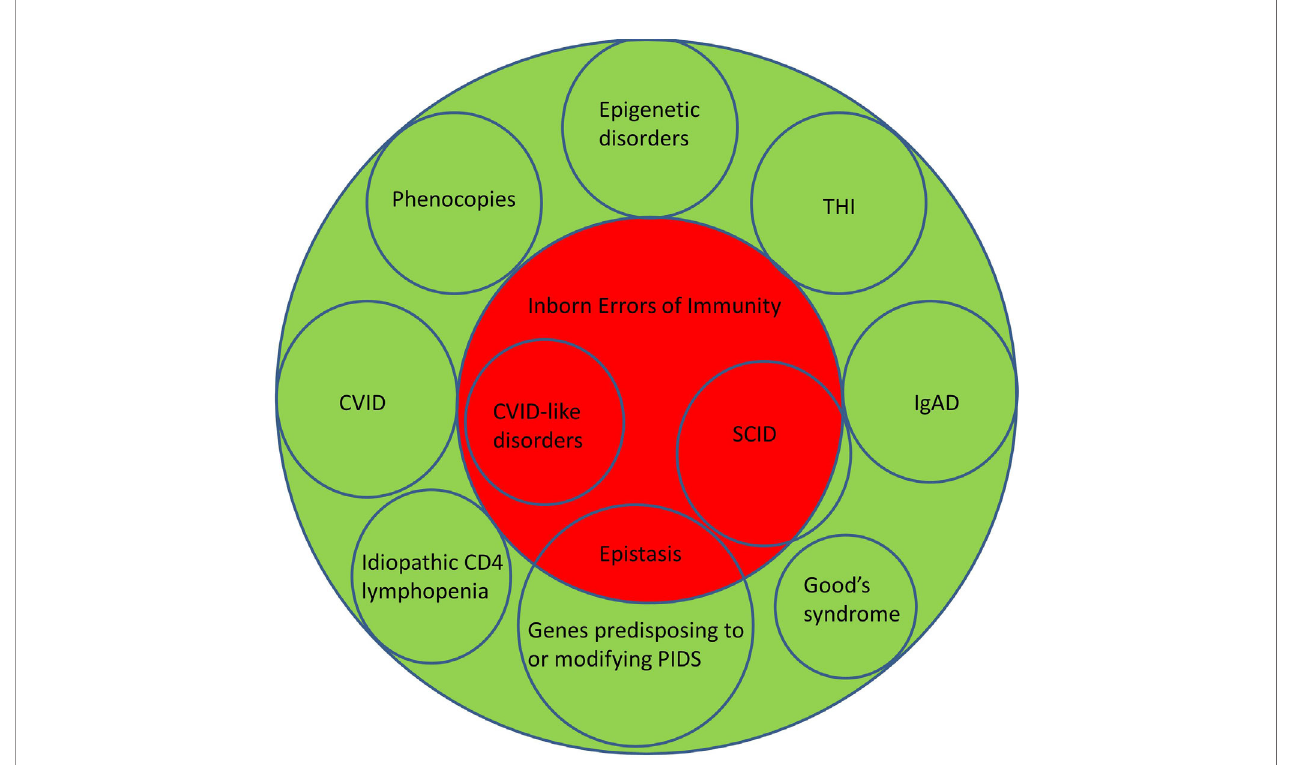
FIGURE 1 | Illustrating the relationship between Primary Immunode fi ciency Disorders (green) and Inborn Errors of Immunity (red). CVID, Common Variable Immunode fi ciency Disorders; IgAD, IgA de fi ciency; SCID, Severe Combined Immunode fi ciency; THI, Transient Hypogammaglobulinemia of